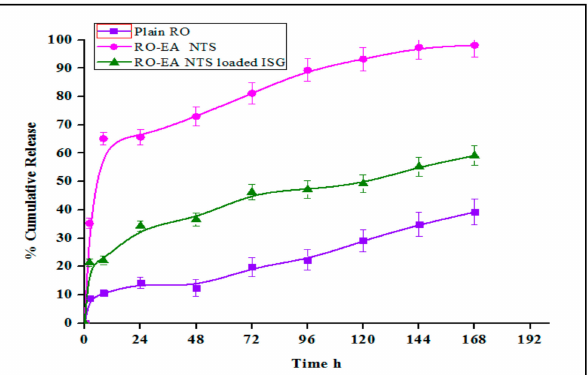
Figure 8. Comparative in-vitro release profiles of plain RO aqueous dispersion, RO-EA-NTS aqueous dispersion, and RO-EA-NTS loaded in situ gel formulations.